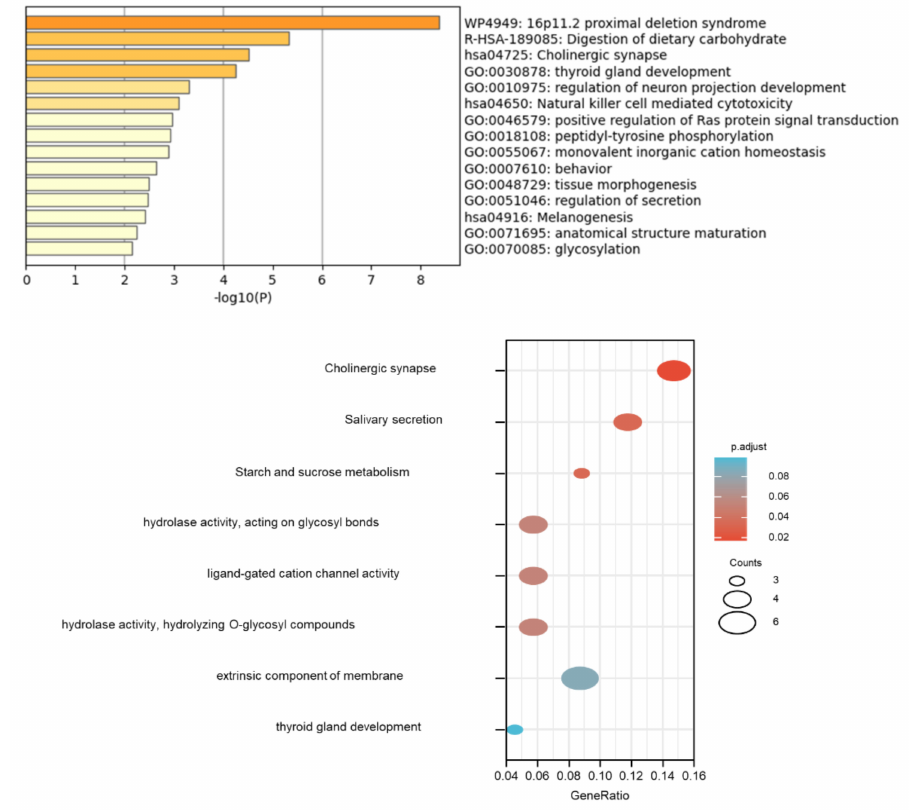
Figure 6. Dental-caries- and periodontitis-related genes in the enrichment of GO and